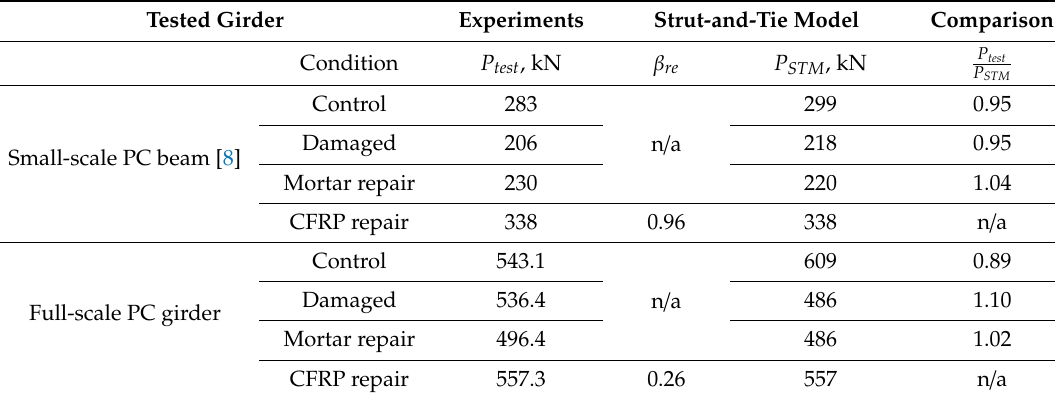
Table 3. Comparison of results between experiments and strut-and-tie model (STM). Tested Girder Experiments Strut-and-Tie Model Comparison Condition P test , kN β re P STM , kN P test